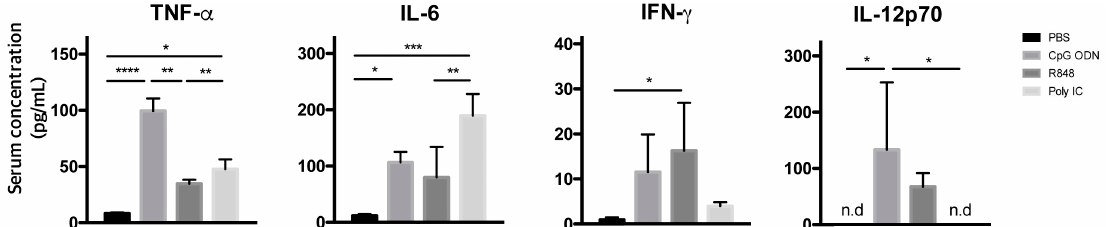
Figure A3. Evaluation of pro-inflammatory cytokine response induced by endosomal TLR agonists